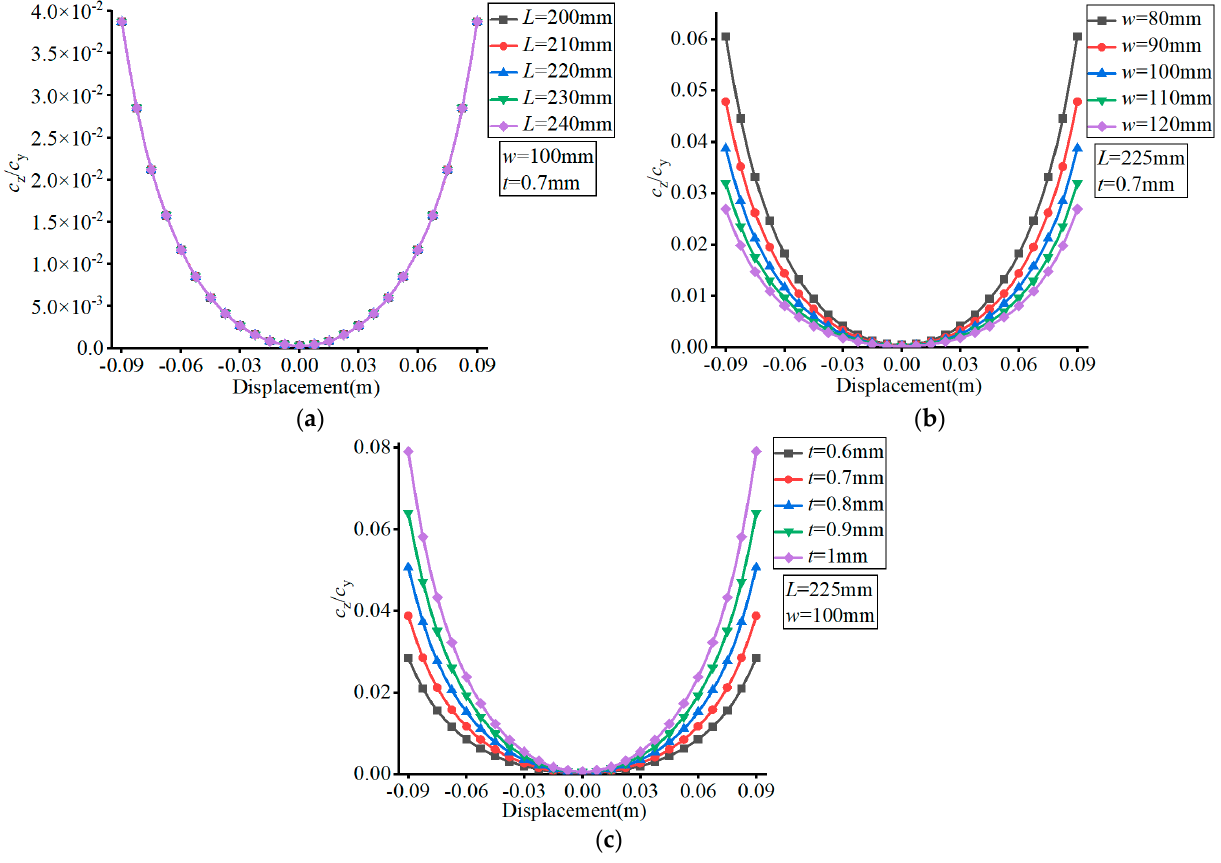
Figure 9. Effect of structural parameters on c z / c y . ( a ) Effect of L ; ( b ) Effect of w ; ( c ) Effect of t .